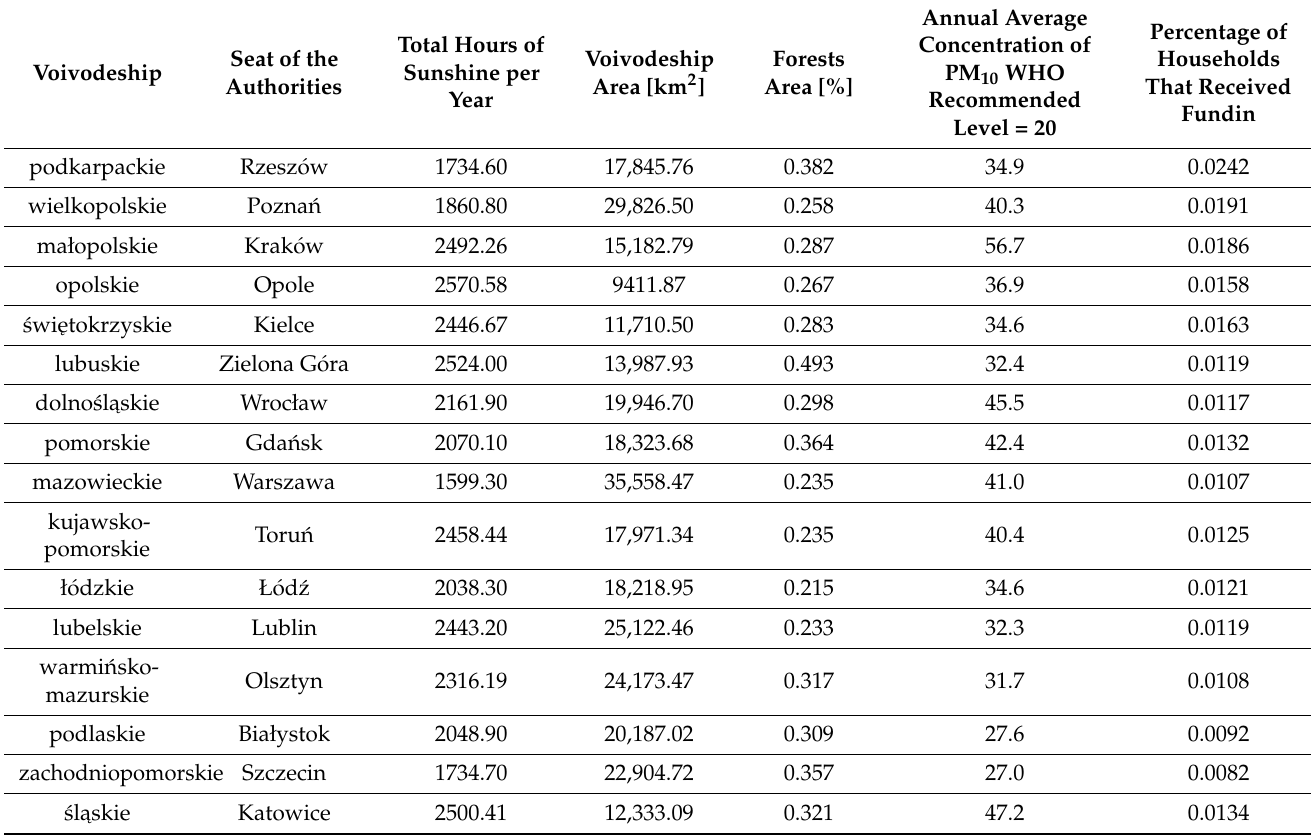
Table A2. The input data for